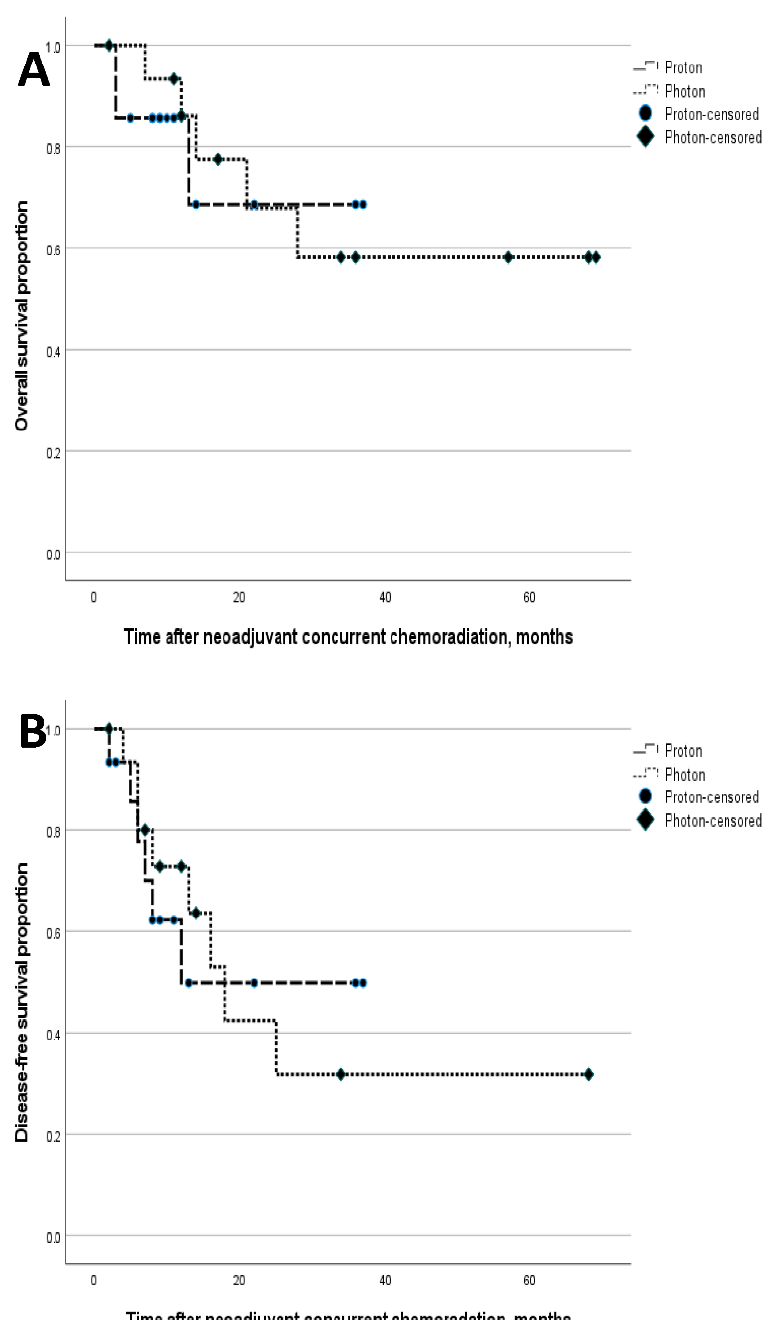
Figure 3. The survival results, overall survival ( A ) and disease-free survival ( B ) of locally advanced esophageal squamous cell carcinoma patients with neoadjuvant chemoradiotherapy according to the radiation modalities, photon, and